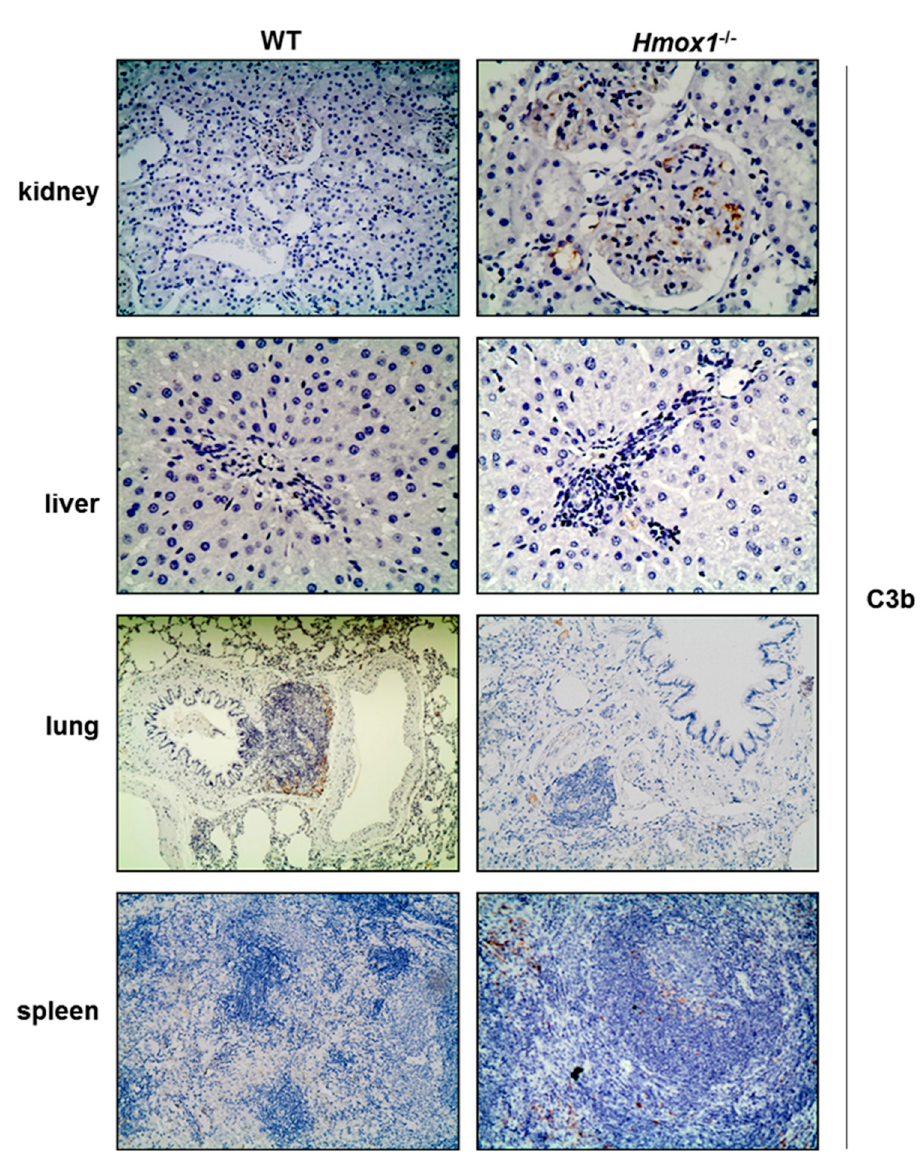
Figure 4. C3b staining of WT and Η mox1 − / − rat tissue sections. Staining of C3b was detected in kidney, lung and spleen tissues sections. Magnification ×200.